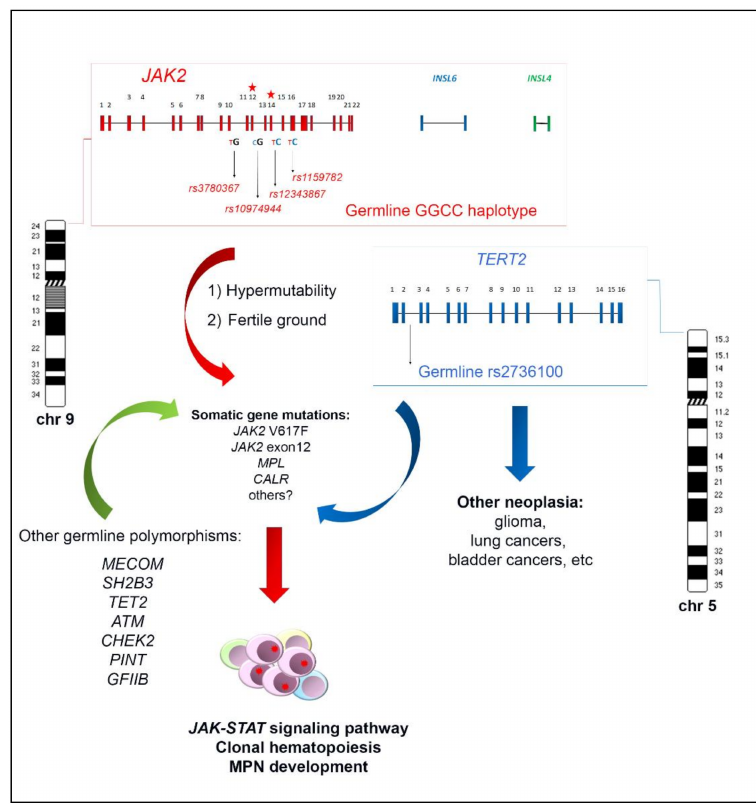
Figure 1. Schematic representation of the JAK2 haplotype GGCC_46/1 genomic architecture and its possible interplay with the germline TERT rs2736100 in inducing somatic gene mutations, clonal expansion and MPN onset. Red, blu and green arrows refer to the possible induction of somatic gene mutations by the JAK2 haplotype GGCC_46/1 , TERT rs2736100, and other germline polymorphisms,